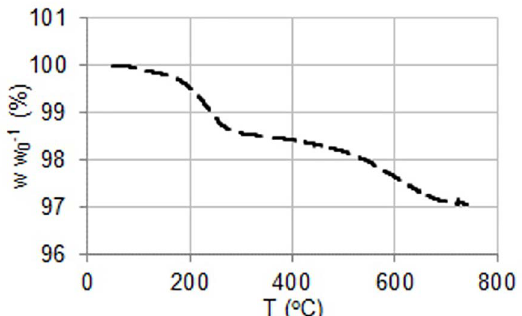
SiO under N atmosphere. Figure 5. Thermal decomposition of Li 4 4 2 Thought, the experimental decarbonation temperature is much lower than that found for CaO, as previously described. According to Fig. 6 (b), at 0.15 atm of CO , the 2 carbonation reaction occurs in the temperature range of 450-640 o C, with a CO uptake of 2.8 wt.%. Thus, the 2 isothermal capture experiments should be performed at temperatures lower than 640 o C. In addition, the temperature of 750 o C is adequate to guarantee the decarbonation reaction of the solid, independent of the CO concentration 2 in the gas stream 24